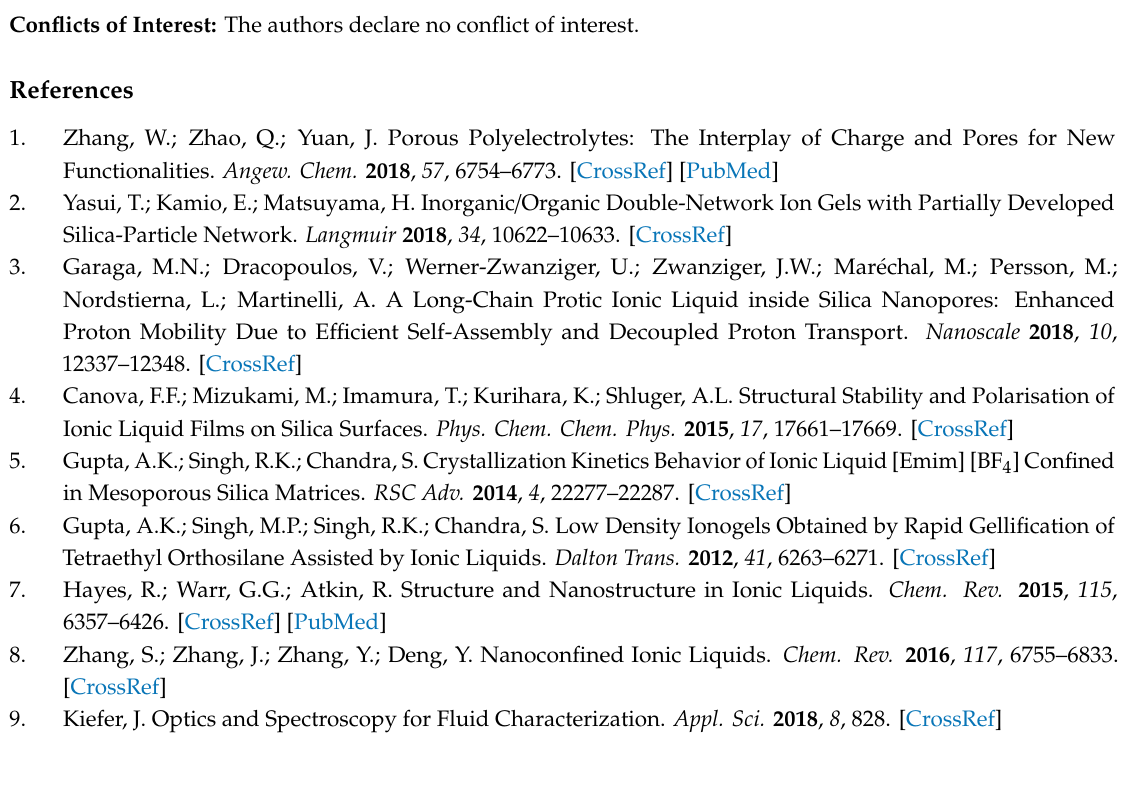
Figure S1: Infrared spectra of (a) pure [C 4 C 1 Im][BF 4 ] and (b) [C 4 C 1 Im][BF 4 ] in a silica matrix, recorded at ambient pressure, Figure S2: Pressure dependence of the C–H stretching frequencies at 2967 cm − 1 of the pure [C 4 C 1 Im][BF 4 ] (squares) and [C 4 C 1 Im][BF 4 ] in a silica matrix (diamonds). Figure S3: Infrared spectra of the pure [C 4 C 1 Im][PF 6 ] obtained at (a) ambient pressure and at (b) 0.4, (c) 0.7, (d) 1.1, (e) 1.5, (f) 1.8, (g) 2.5 GPa, and (h) back to ambient. Figure S4: Infrared spectra of [C 4 C 1 Im][PF 6 ] in a silica matrix obtained at (a) ambient pressure and at (b) 0.4, (c) 0.7, (d) 1.1, (e) 1.5, (f) 1.8, and (g) 2.5 GPa. Figure S5: Pressure dependence of the C–H stretching frequencies at 3170 cm − 1 of the pure [C 4 C 1 Im][PF 6 ] (squares) and [C 4 C 1 Im][PF 6 ] in a silica matrix